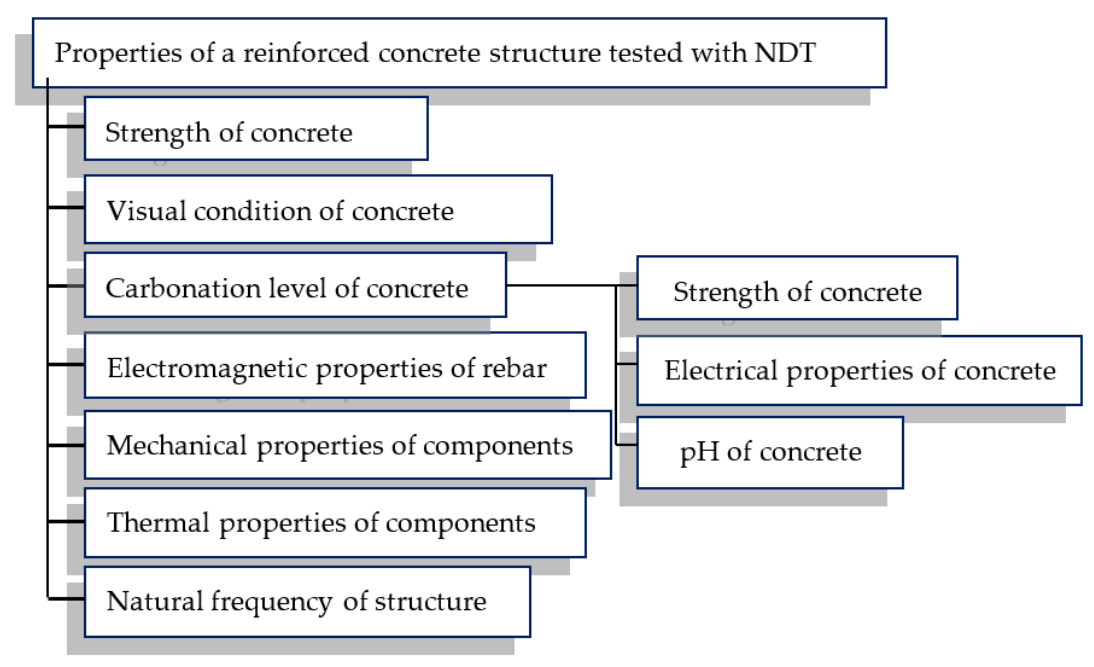
Figure 1. Properties of reinforced concrete structures that can be examined by NDT methods.